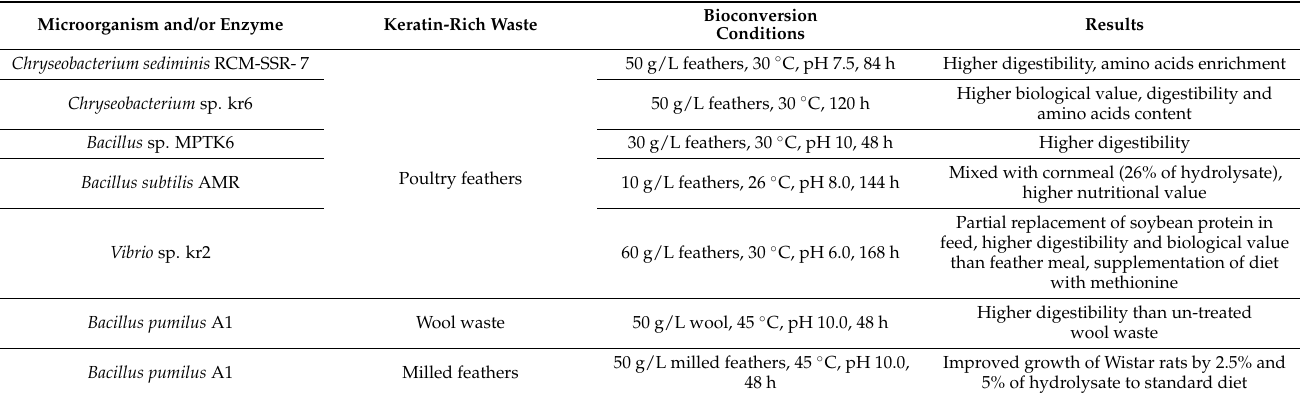
Table 9. Examples of keratinolytic microorganism utilized for bioconversion of keratin waste into animal feed [135,153]. Microorganism and/or